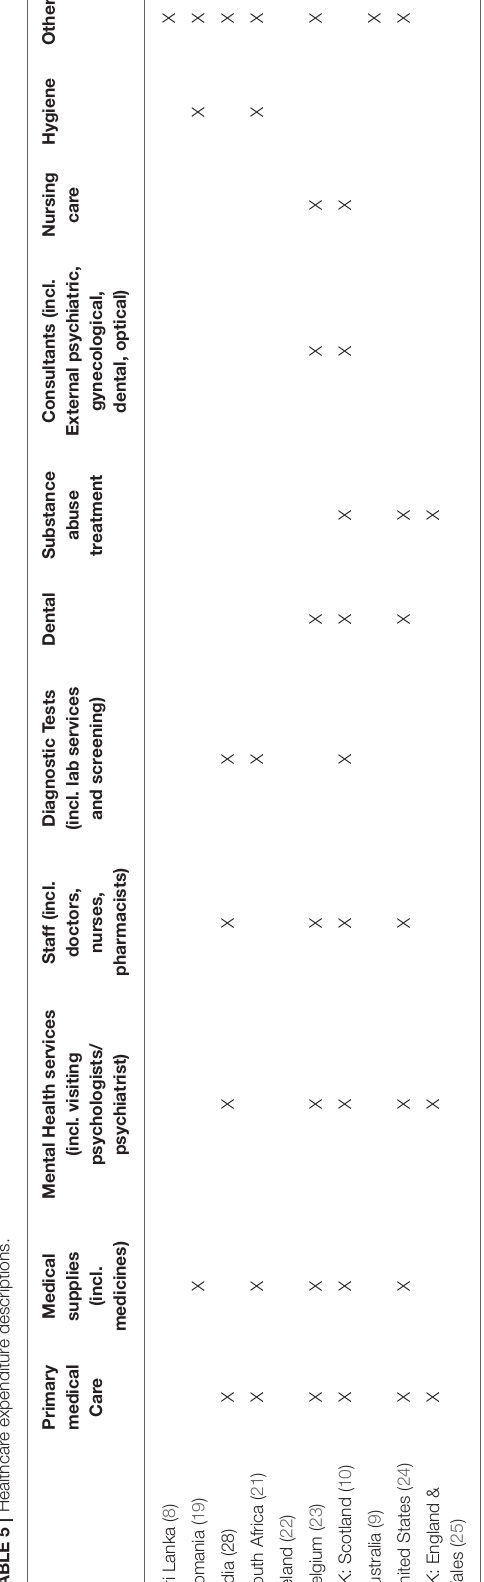
TABLE 3 | Reported annual healthcare expenditure per prisoner.